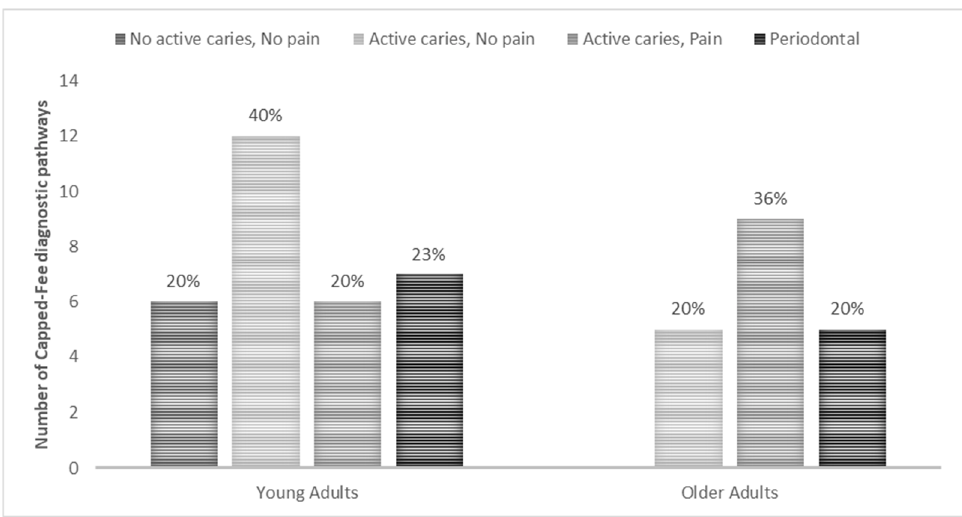
Figure 1. Participants’ dental care through the Capped-fee diagnostic pathways.